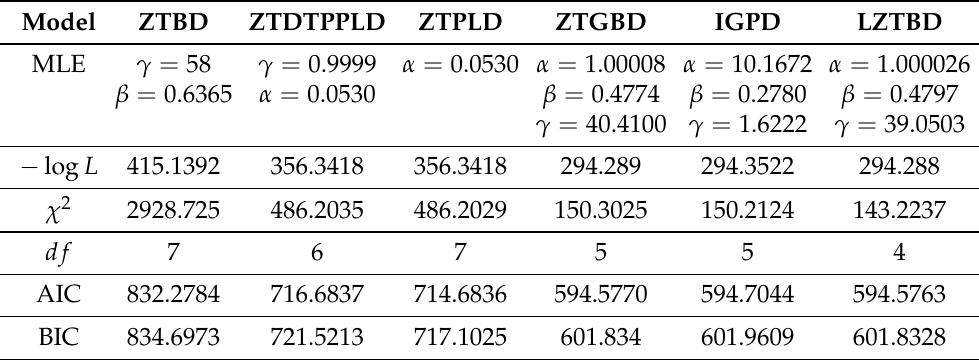
Table 10. Maximum likelihood estimates (MLEs), model adequacy measures, and χ 2 value for the Saudi Arabia data set.